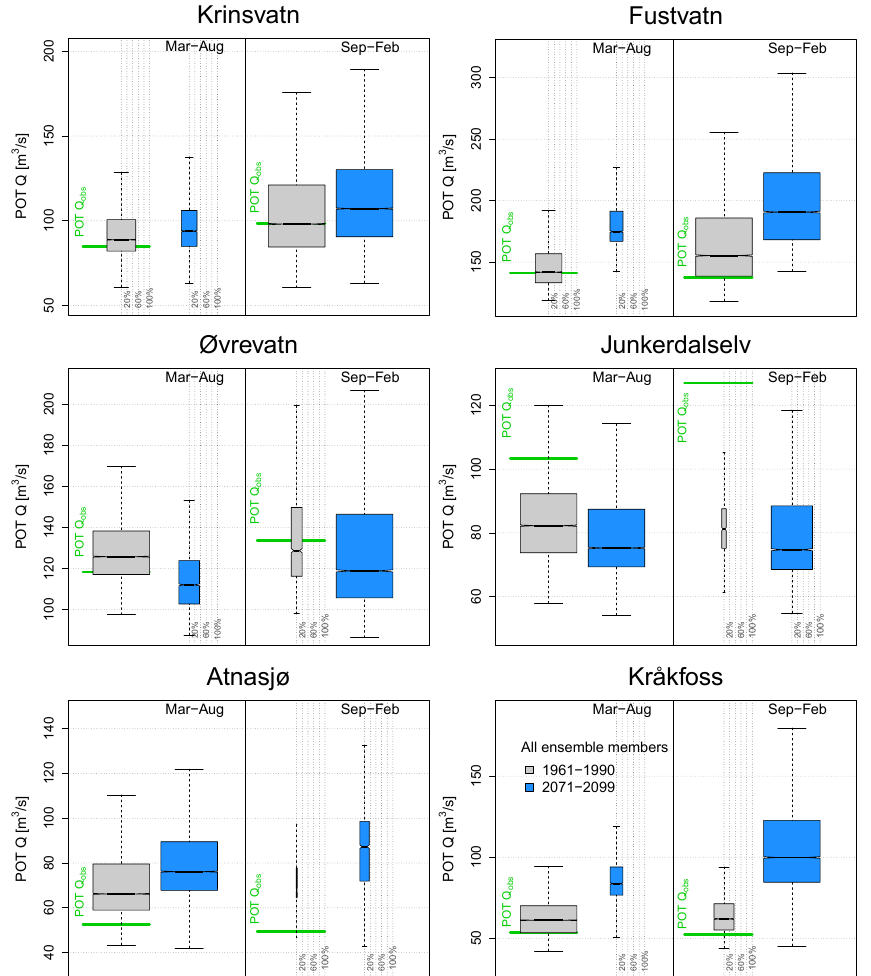
Figure 5. Boxplots showing the median and interquartile magnitudes of the simulated POT events from all ensemble realizations for the reference (grey boxes) and future periods (blue boxes), separated with respect to the two basic flood seasons in Norway (spring/summer – left panels; autumn/winter – right panels). The whisker range corresponds to twice the interquartile range. The green bars (POT obs ) indicate the median magnitudes of observed POT events. The width of the boxes illustrates the seasonal distribution in the frequency of the POT events: Per catchment and period, the smaller boxes are scaled compared to the larger boxes representing the dominant flood season in terms of flood